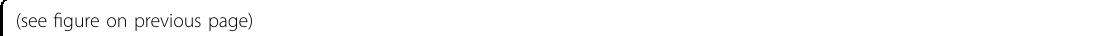
Fig. 5 Geometric cue-coordinated cell adhesions are able to rescue the myogenic defects caused by kinesin-1 inhibition. a A polydimethylsiloxane (PDMS) stamp with micron-sized features (20 µm or 50 µm stripes) were shown in phase images. b Images of C2C12 cells plated on 20 µm or 50 µm stripe micropatterns; these were stained for fi bronectin (to visualize stripe micropatterns; green), paxillin (to visualize FAs; red) and DAPI (to visualize nucleus; blue). c C2C12 cells expressing non-silenced (shControl) or kinesin-1-silenced (shKIF5B) shRNAs were plated on fi bronectin-coated coverslips (with no pattern substrate), 20 µm striped coverslips or 50 µm striped coverslips, treated with differentiation medium for 5 days and immunostained for MYH1/2 (yellow; myotube marker) and DAPI (to visualize nucleus). Scale bar, 50 µm. d Aspect ratio, calculated as a ratio of the longest cell length to the shortest cell length in MYH1/2 + cells with nuclei <3 ( n < 3) or nuclei ≥ 3 ( n ≥ 3), as shown in c . Data are mean ± s.e.m (shControl with no pattern with <3 nuclei, n = 68 MYH1/2 + cells; shControl on 50 µm stripes with <3 nuclei, n = 34 MYH1/2 + cells; shControl on 20 µm stripes with <3 nuclei, n = 24 MYH1/2 + cells; shKIF5B with no pattern with <3 nuclei, n = 168 MYH1/2 + cells; shKIF5B on 50 µm stripes with <3 nuclei, n = 65 MYH1/2 + cells; shKIF5B on 20 µm stripes with <3 nuclei, n = 38 MYH1/2 + cells; shControl with no pattern with ≥ 3 nuclei, n = 45 MYH1/2 + cells; shControl on 50 µm stripes with ≥ 3 nuclei, n = 52 MYH1/2 + cells; shControl on 20 µm stripes with ≥ 3 nuclei, n = 21 MYH1/2 + cells; shKIF5B with no pattern with ≥ 3 nuclei, n = 23 MYH1/2 + cells; shKIF5B on 50 µm stripes with ≥ 3 nuclei, n = 25 MYH1/2 + cells; shKIF5B on 20 µm stripes with ≥ 3 nuclei, n = 23 MYH1/2 + cells). ** p < 0.01; *** p < 0.001; NS no signi fi cance. e C2C12 cells expressing non-silenced (shControl) or kinesin-1-silenced (shKIF5B) shRNAs were plated on fi bronectin-coated coverslips (with no pattern substrate), 20 µm striped coverslips or 50 µm striped coverslips for 24 h and immunostained for Tom20 (green; to visualize mitochondria), α -tubulin (red; to visualize microtubules), and DAPI (to visualize nucleus). Scale bar, 50 µm. f Percentage of mitochondria area (marked with Tom20) within a cell (marked with α -tubulin), as shown in e . Data are mean ± s.e.m (shControl with no pattern, n = 32 cells; shControl on 50 µm stripes, n = 22 cells; shControl on 20 µm stripes, n = 20 cells; shKIF5B with no pattern, n = 39 cells; shKIF5B on 50 µm stripes, n = 34 cells; shKIF5B on 20 µm stripes, n = 20 cells). ** p < 0.01; *** p < 0.001. g Fusion index, calculated as the percentage of nuclei ( ≥ 3) in MYH1/2 + cells, as shown in c . Data are mean ± s.e.m (shControl with no pattern, n = 154 MYH1/2 + cells; shControl on 50 µm stripes, n = 112 MYH1/2 + cells; shControl on 20 µm stripes, n = 53 MYH1/2 + cells; shKIF5B with no pattern, n = 165 MYH1/